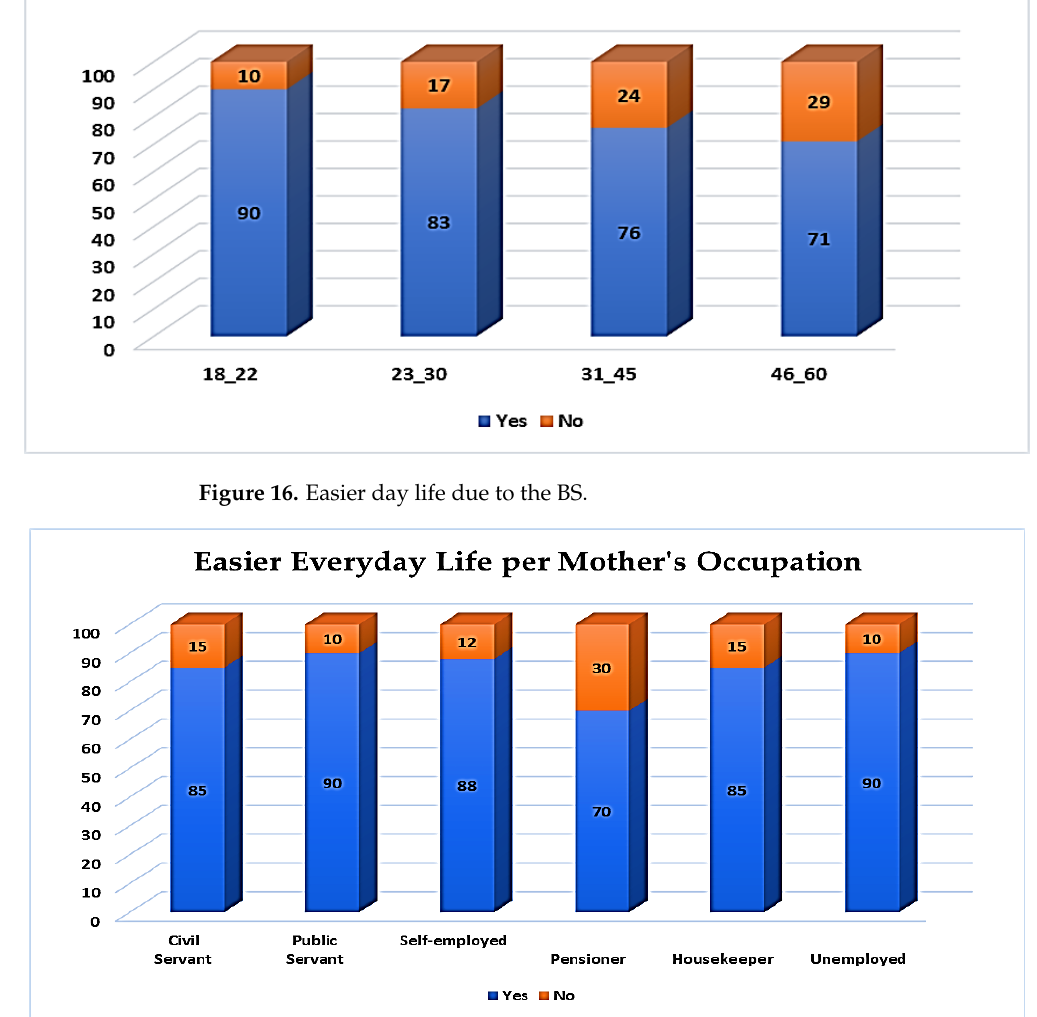
Figure 17. Easier daily life per mother’s occupation.